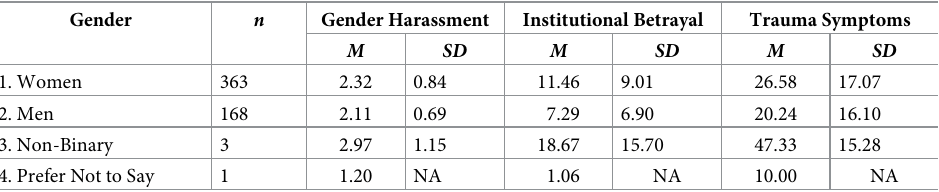
M and SD are used to represent mean and standard deviation, respectively.